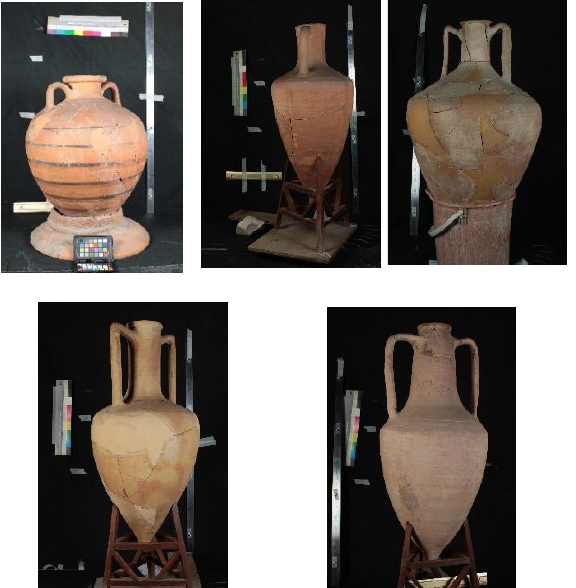
Figure 2. 3D models of amphorae from Athens, Chios, Kos, Rhodes and Knidos (from top left )